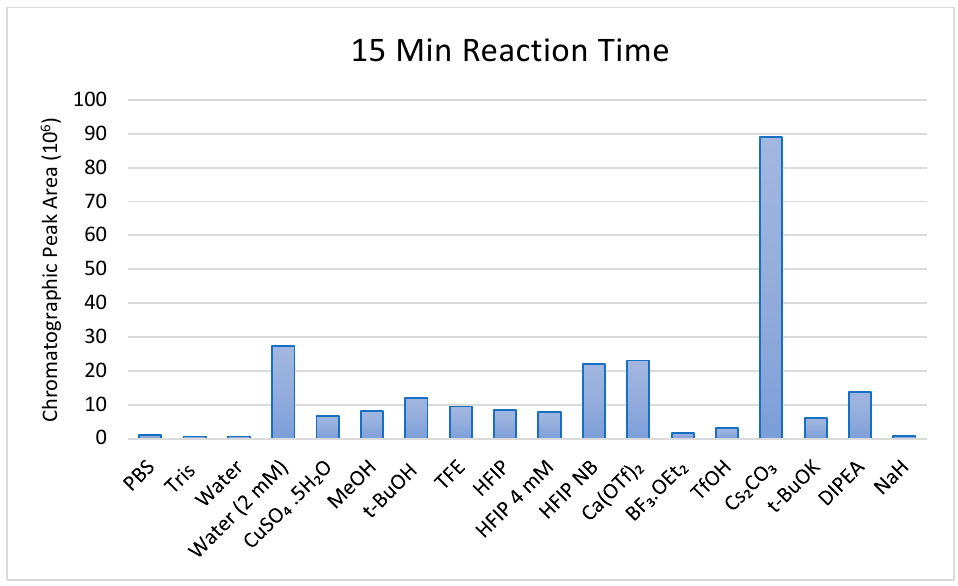
Figure 2. HPLC-MS investigation for bioconjugation of 4-[4-(methoxy)phenyl]-1,2,4-triazole-3,5-dione ( 5f ) with N-acetyl tyrosine ( 7 ) in the presence of various potential catalysts.